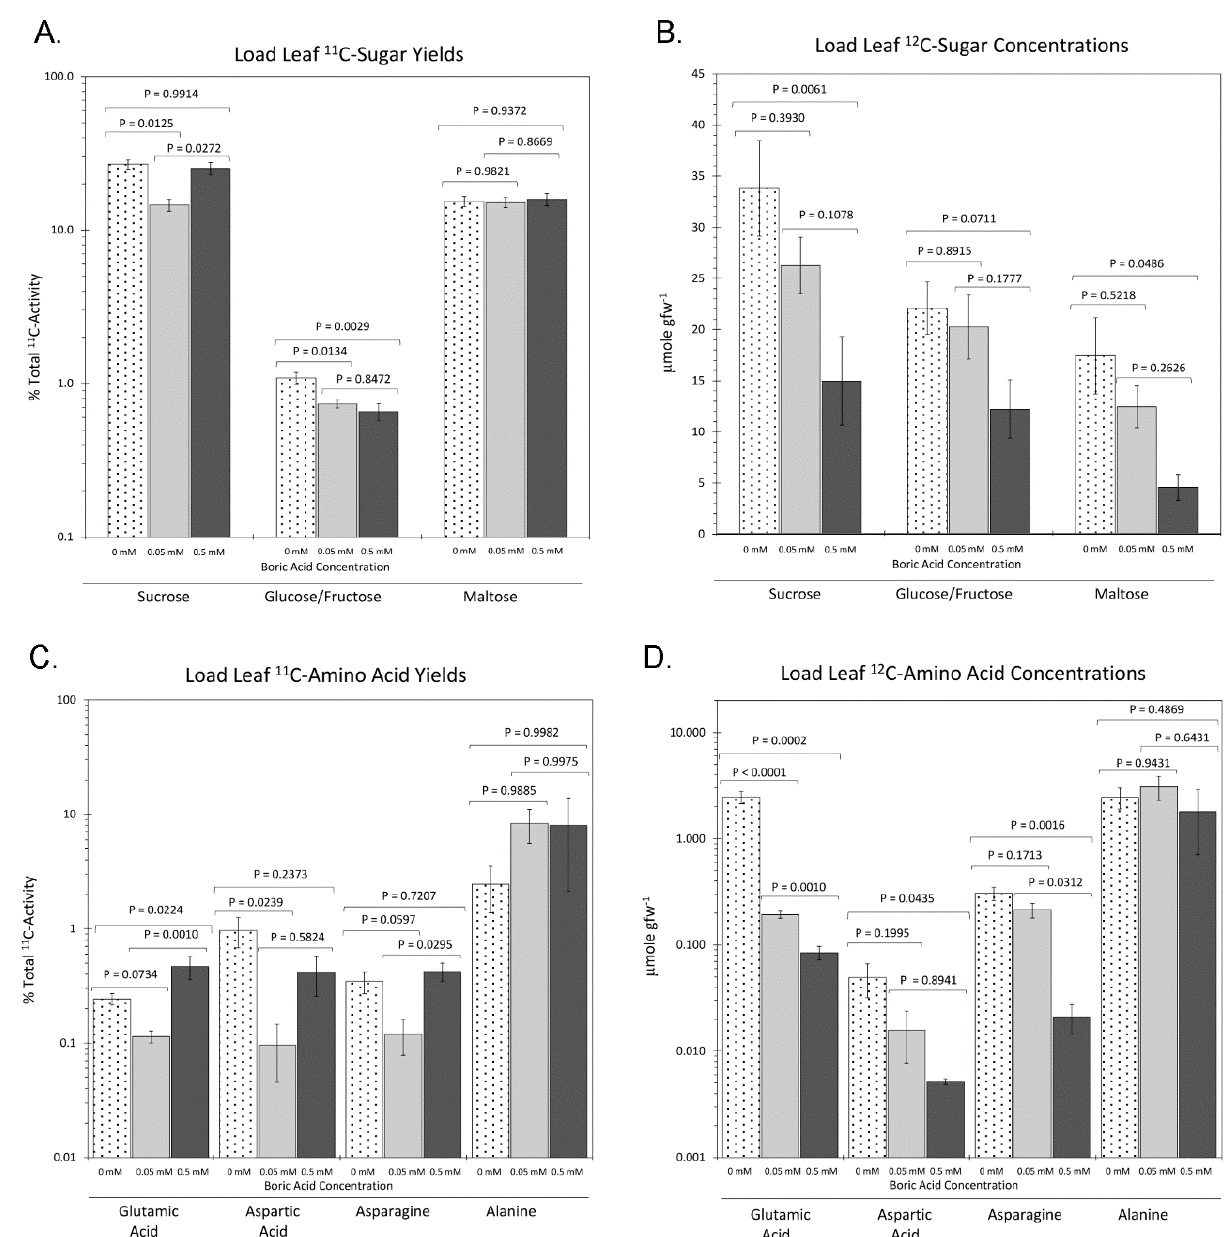
Figure 6. Individual 11 C and 12 C metabolite yields from the soluble sugar pool and amino acid pool as a function of plant growth under three regimes of boric acid (BA) treatment, including: 0 mM BA, 0.05 mM BA, and 0.5 mM BA. ( A ) depicts 11 C-sugars yields measured in the load leaf 20 min after the administration of radioactivity. Data is presented as percent total 11 C activity that the plant acquired from the pulse. ( B ) depicts the endogenous concentrations of the soluble sugars observed in the load leaf presented as micromoles of sugar per gram fresh weight of leaf tissue (µmol ⋅ gfw − 1 ) used in the analysis. ( C ) depicts selected 11 C-amino acid yields measured in the load leaf 20 min after administration of radioactivity. ( D ) depicts the endogenous concentrations of the same amino acids monitored in panel C within the load leaf presented as micromoles of sugar per gram fresh weight of leaf tissue (µmol ⋅ gfw − 1 ) used in the analysis. All data represent average values ± SE from N = 8–10 replicates. Levels of significance are represented by p values calculated using one-way analysis of variance with a post hoc Tukey’s HSD test to account for multiple comparisons between the different treatment groups (0 mM-to-0.05 mM BA; 0.5 mM-to-0.05 mM BA; and 0 mM-to-0.5 mM BA). Statistical significance was set at p < 0.05.